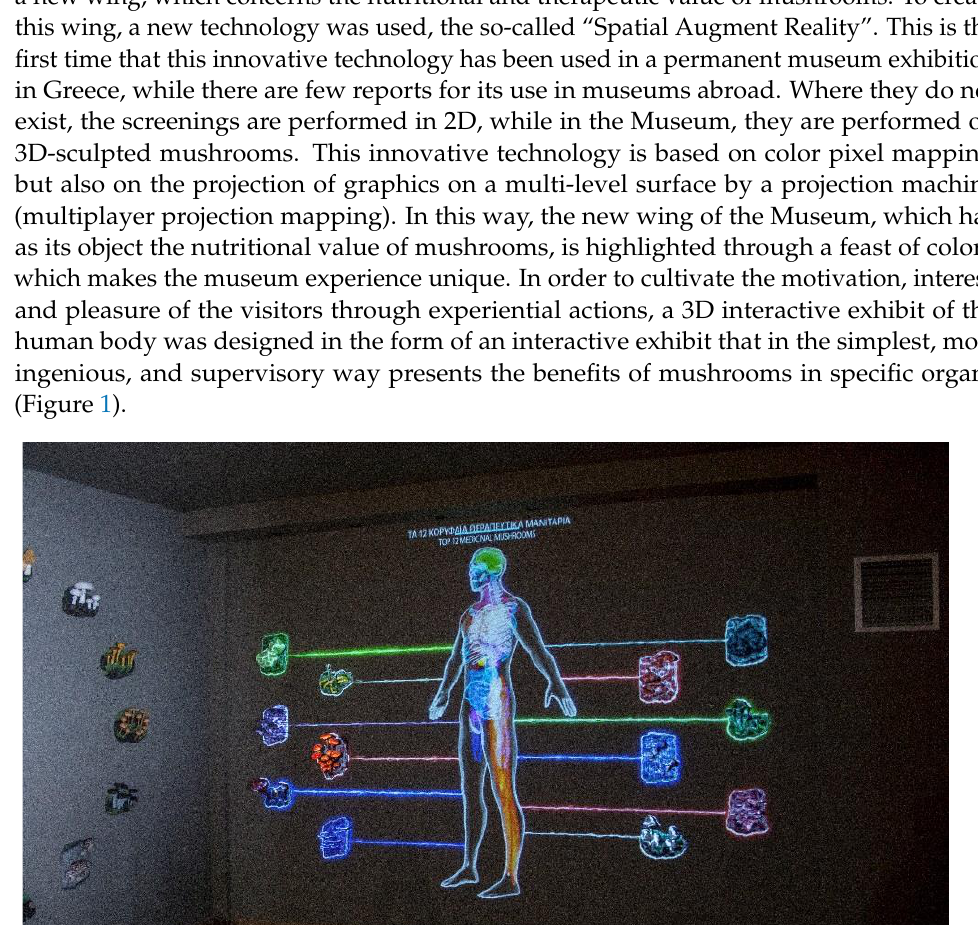
Figure 2. 12 top therapeutic mushrooms.